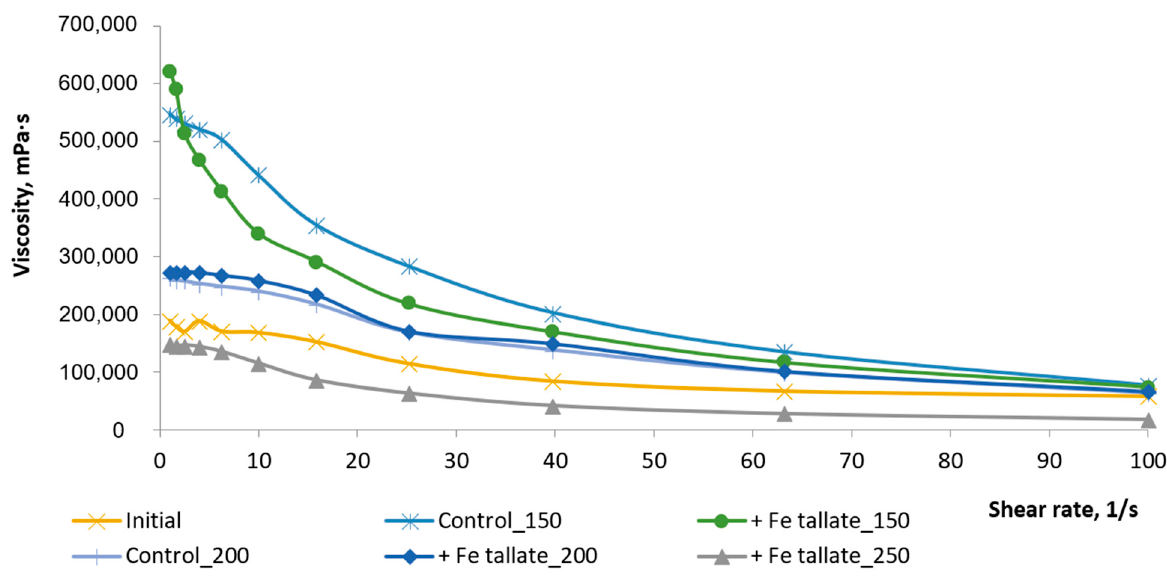
Figure 7. Viscosity-temperature characteristics of control experiment and oils after TST with iron thallate. iron